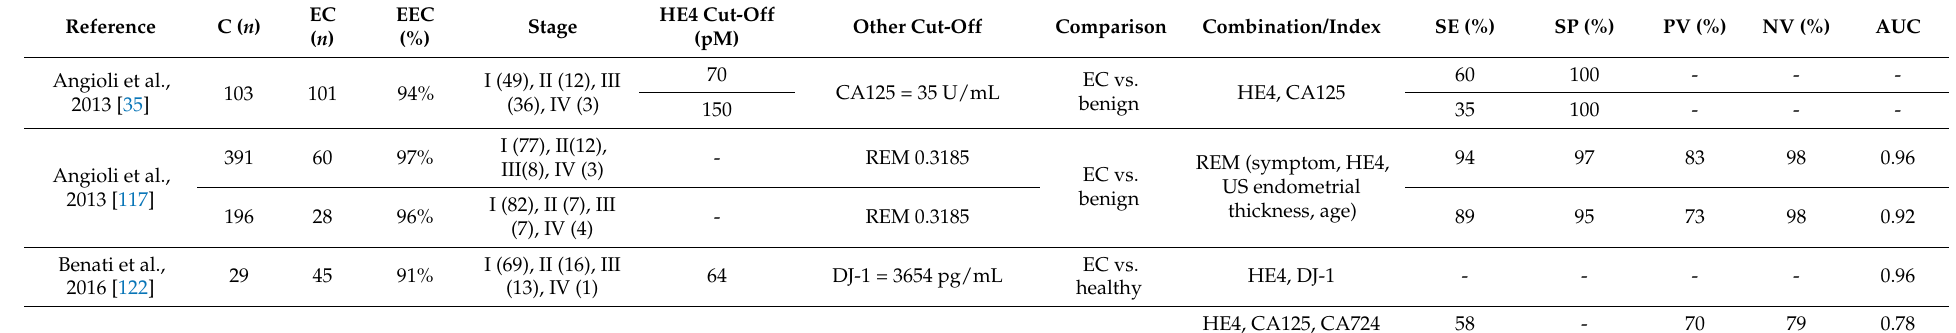
Table 5. HE4 biomarker combinations, cut-off values and their performance in diagnosis of